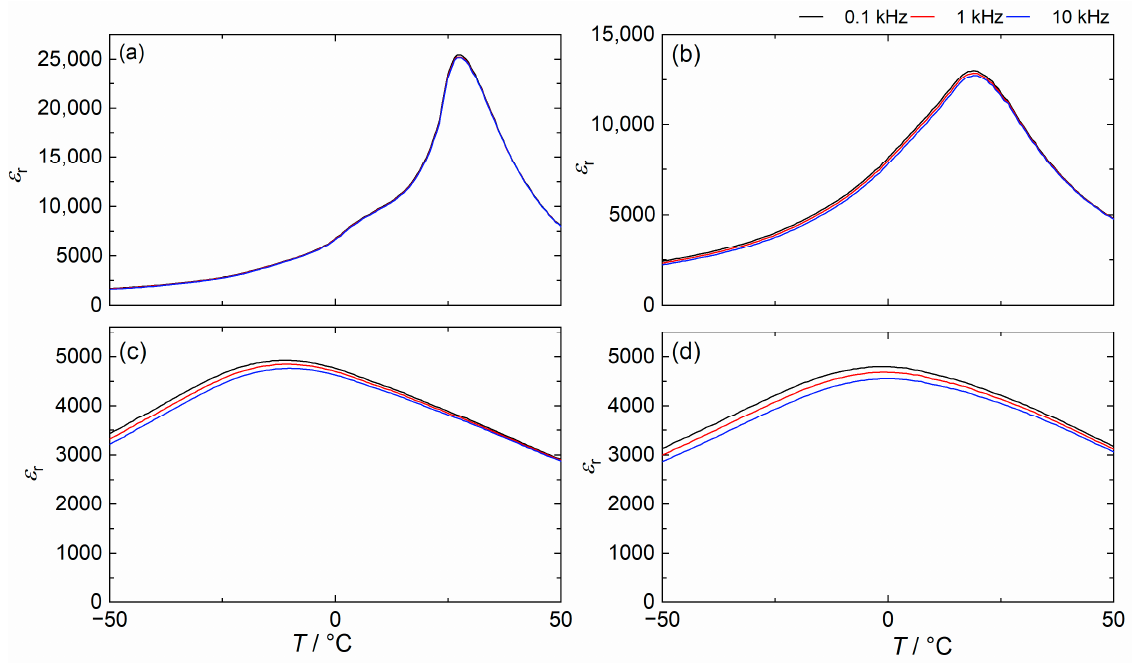
Figure 6. Temperature dependence of ε r measured at different frequencies for BSSnT-18-6.5 ( a ), BSSnT-Cu ( b ), BSSnT-Mg ( c ) and BSSnT-Cu-Mg ( d ).